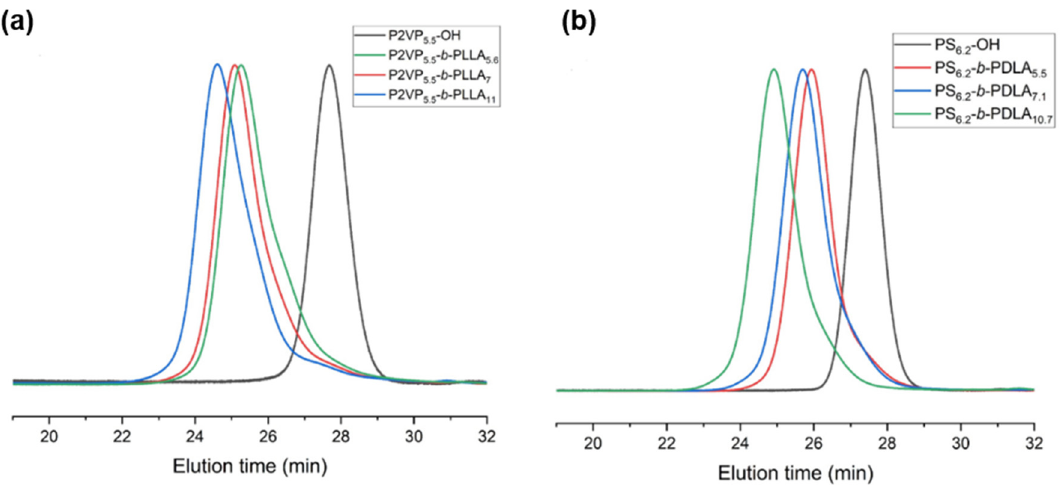
Figure 1. SEC traces of ( a ) P2VP-OH precursor and P2VP- b -PLLA diblock copolymers and ( b ) PS-OH precursor and PS- b -PDLA diblock copolymers (THF as eluent, 35 °C, PS standards).